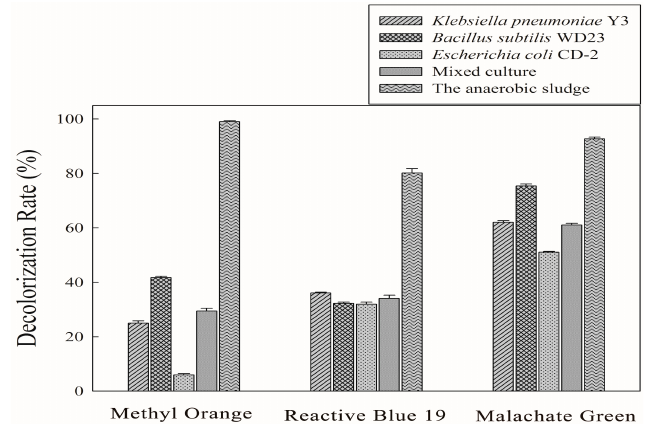
Figure 2. Decolorization performance of Methyl Orange, Reactive Blue 19 and Malachite Green (100 mg · L − 1 ) using pure strains, mixed culture and the anaerobic sludge.